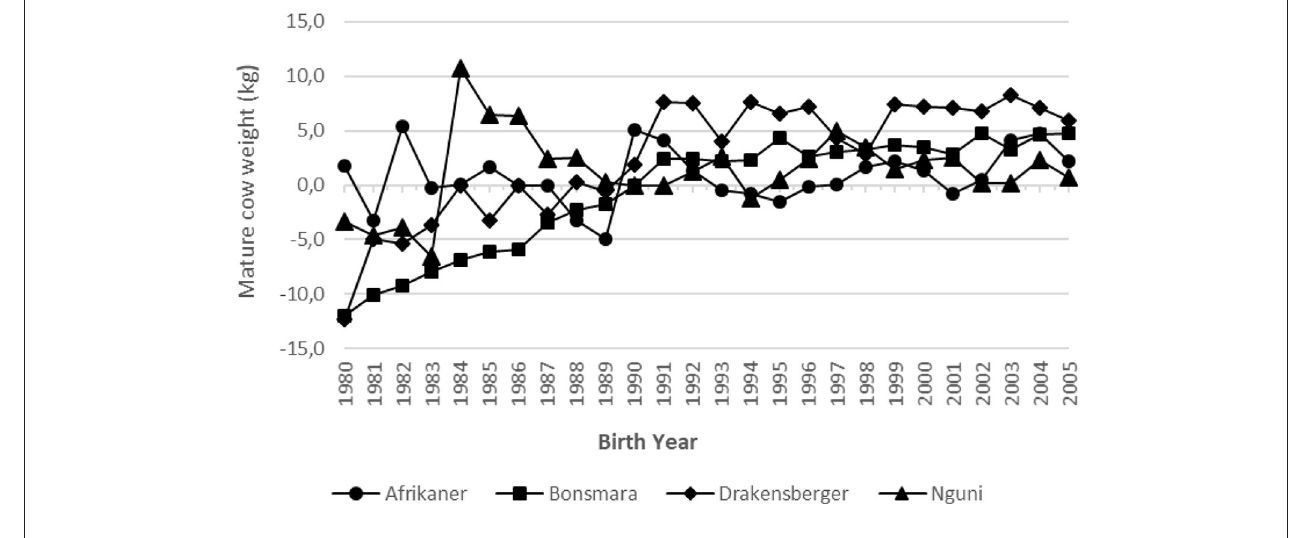
FIGURE 4 | Genetic trend for mature cow weight in the four breeds.